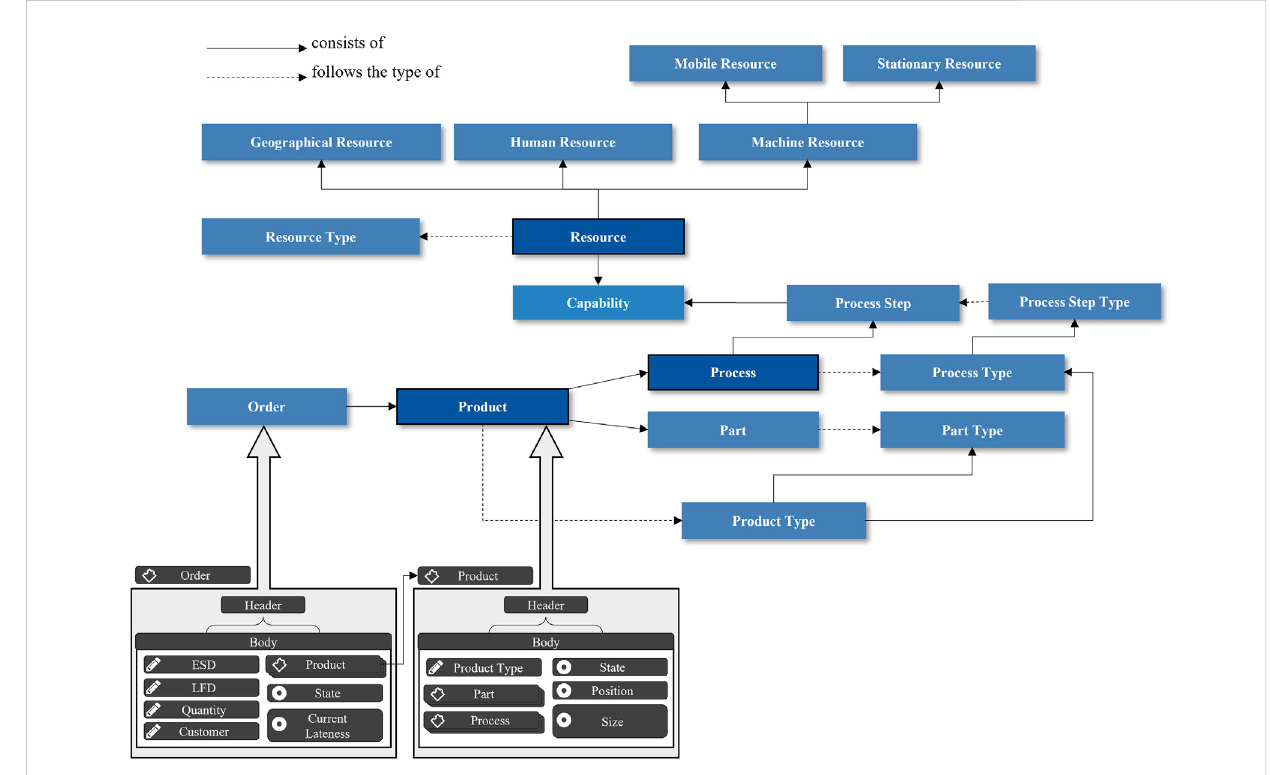
FIGURE 6 Extracted domain-speci fi c custom ontology incorporating established ontologies and meta-models (cf. Göppert et al., 2021a).